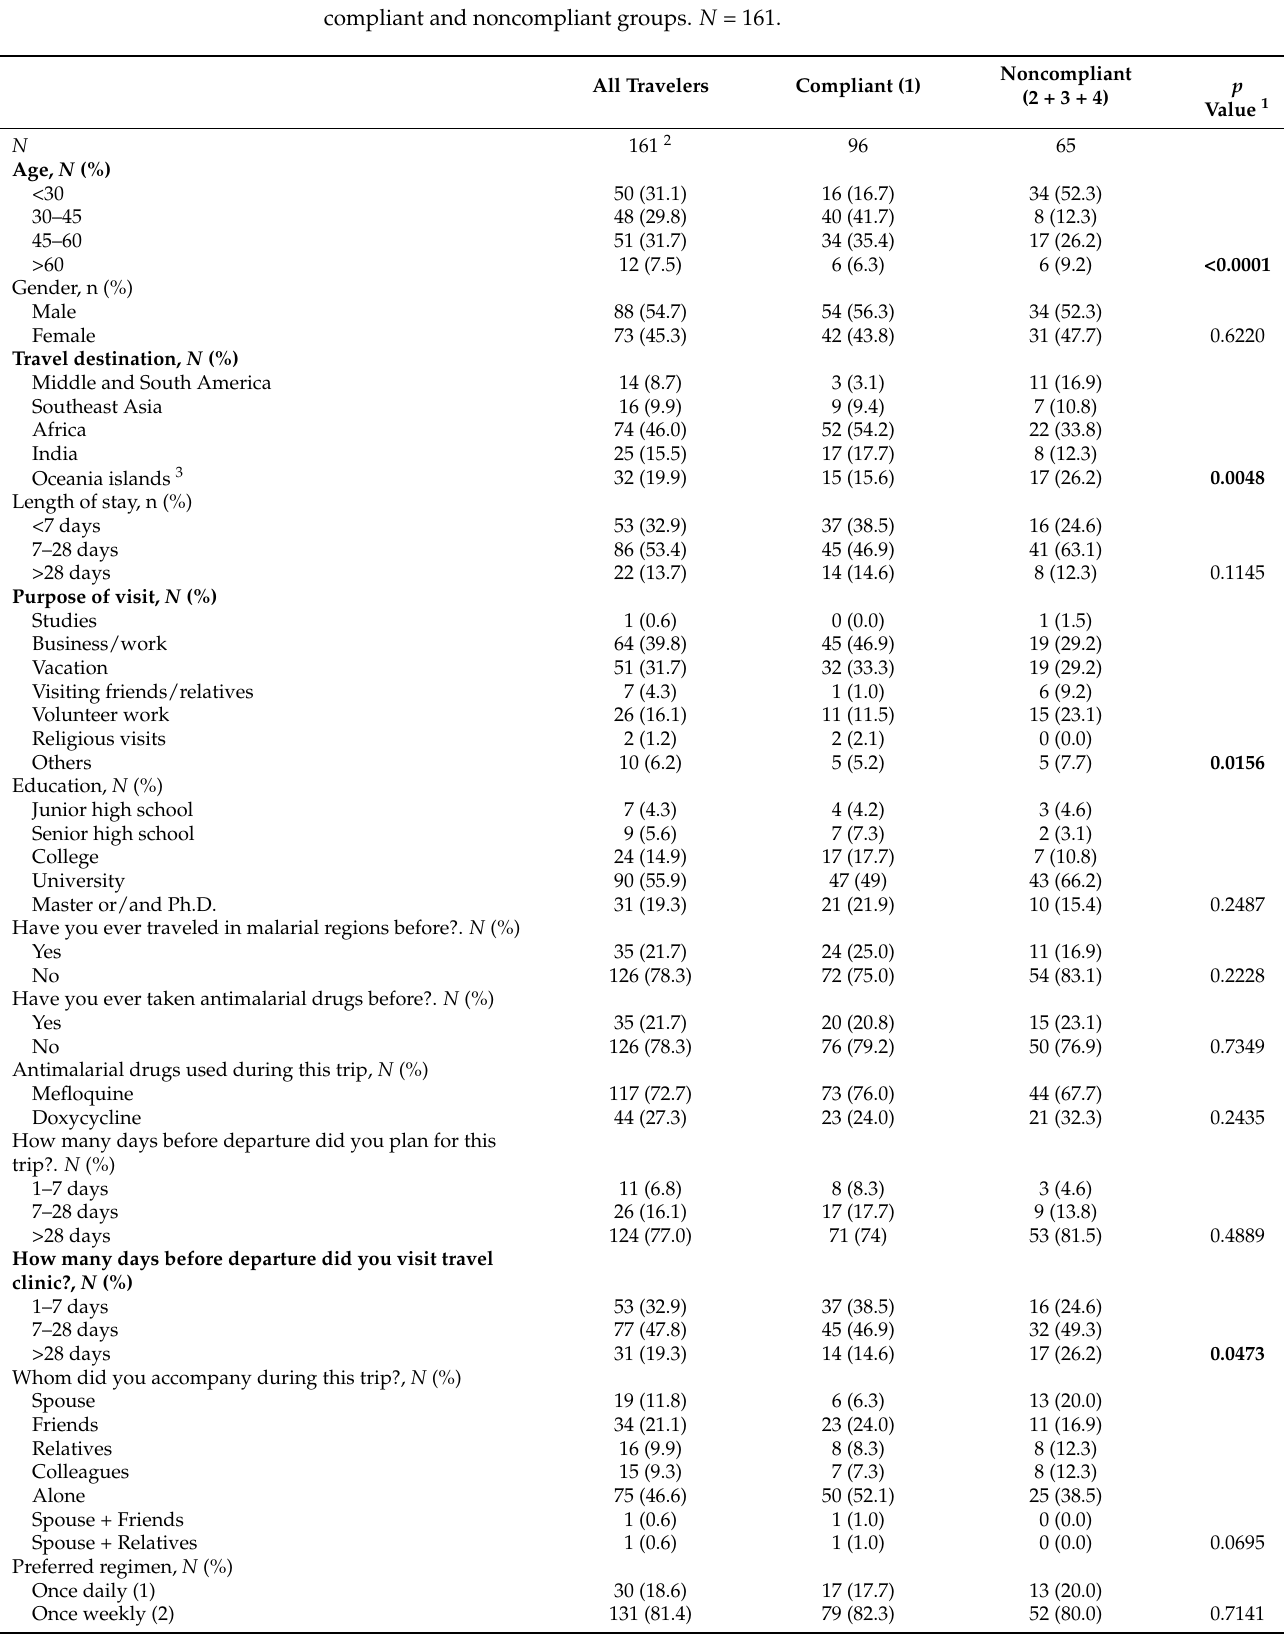
Table 1. Comparisons of sociodemographic characteristics and details of the trip between the compliant and noncompliant groups. N =